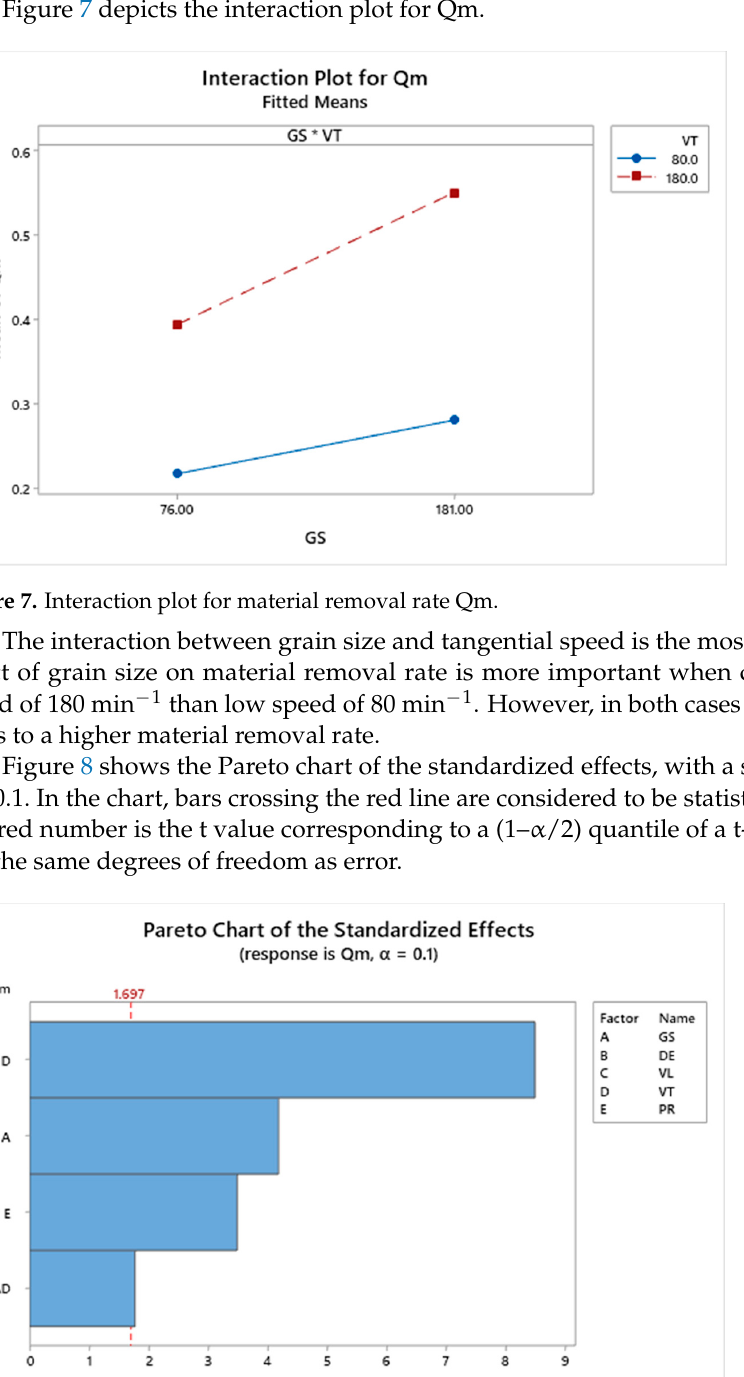
Figure 7 depicts the interaction plot for Qm.